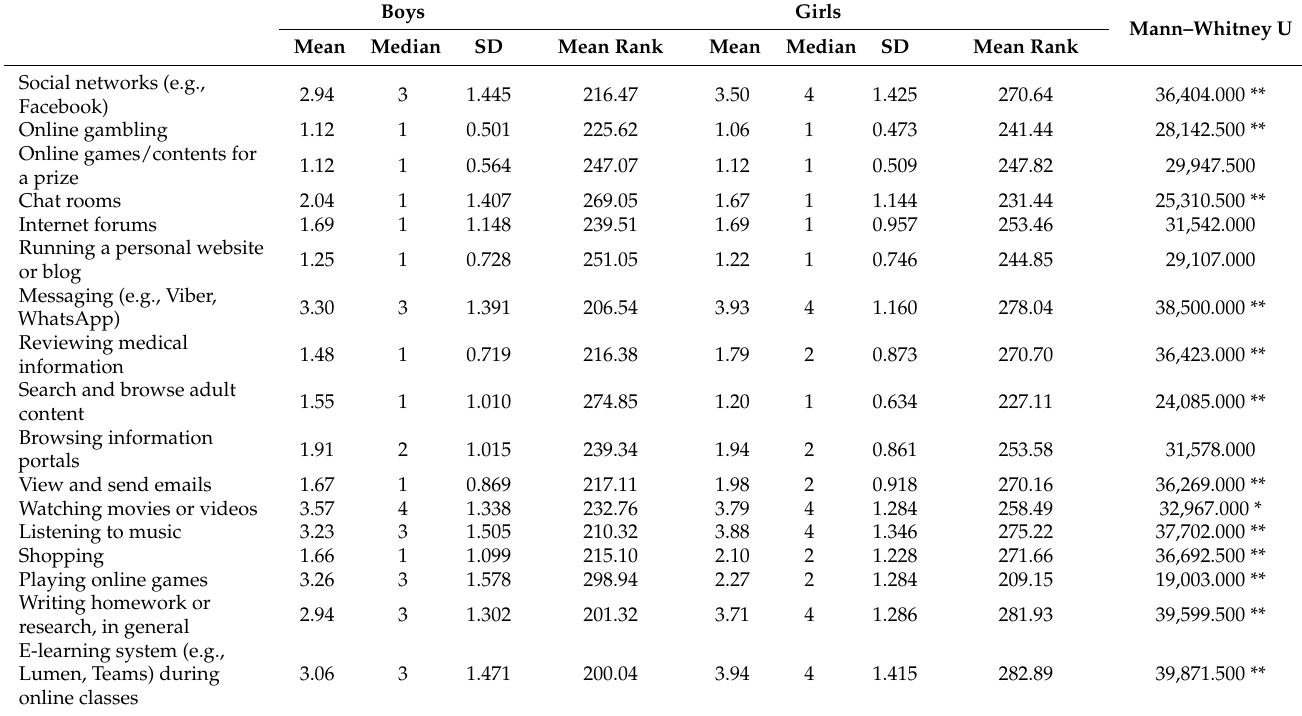
Table 3. Online content use by gender.